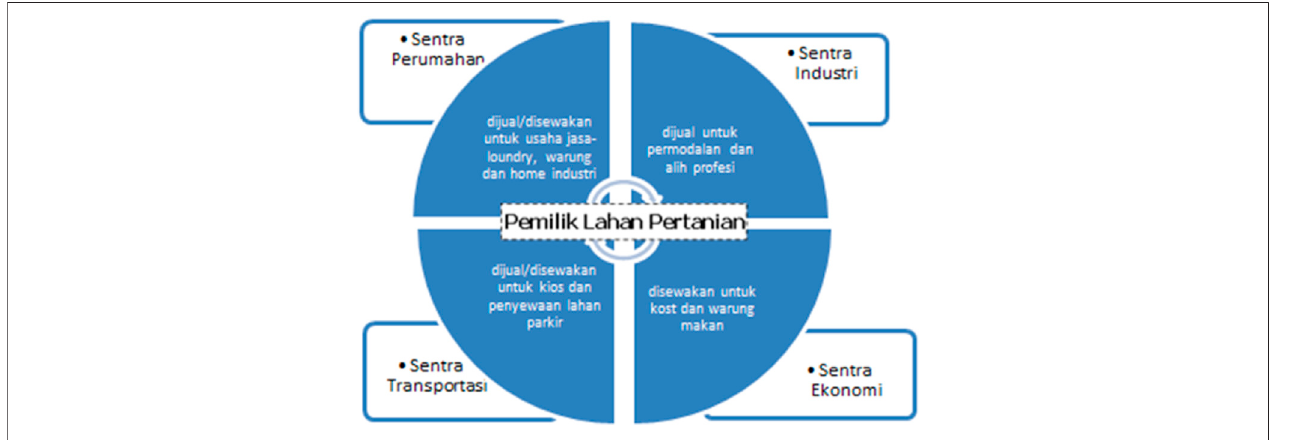
FIGURE 1 | Land use by farming communities in Ngringo